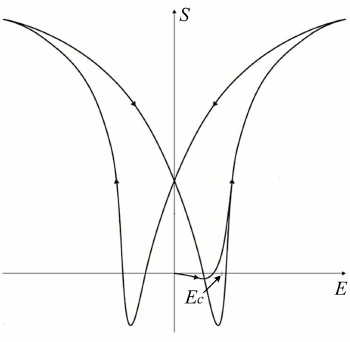
Figure 3. The ideal strain–electric field characteristic of soft piezo ceramic.